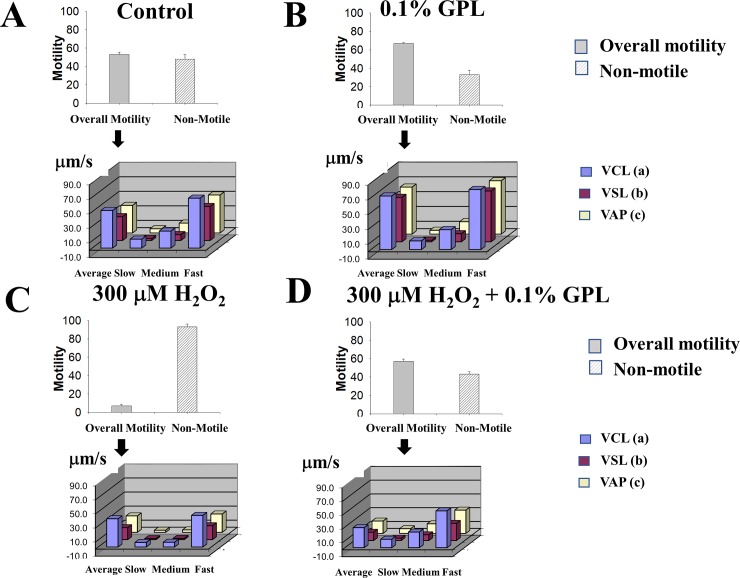
Analysis of motility of mature human sperm from adult males incubated under different experimental conditions (control, GPL, H2O2, GPL plus H2O2).For each experimental condition (listed on the top of each graph set) the percent overall motility (grey bar) and immotile sperm (dashed white bar) are shown. Below these plots are shown the curvilinear velocity (VCL), the straight line velocity (VSL) and the average path velocity (VAP) in μm/s, for each type of sperm motile pattern (average, slow, medium and fast motility)(n = 8 experiments). (A) control (B) 0.1% GPL (C) 300 μM H2O2 (D) 300 μM H2O2 plus 0.1% GPL.